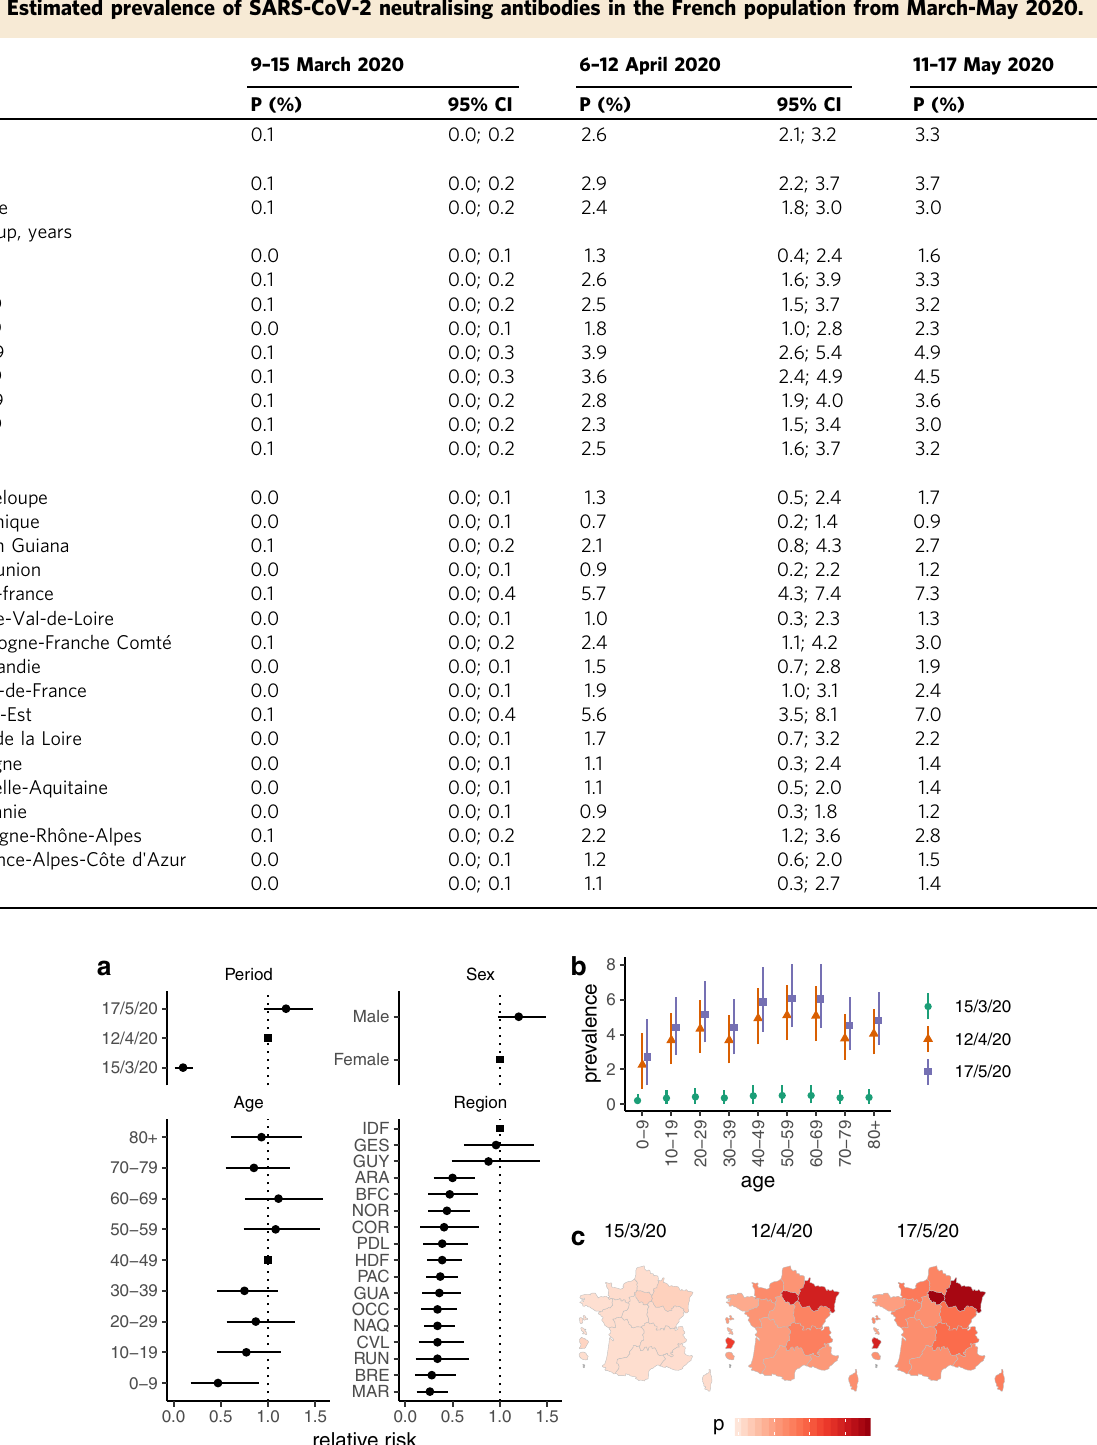
represent mean estimate and bars 95% uncertainty interval of prevalence estimate over 10 4 iterations. c Prevalence of SARS-CoV-2 antibodies in the French population by